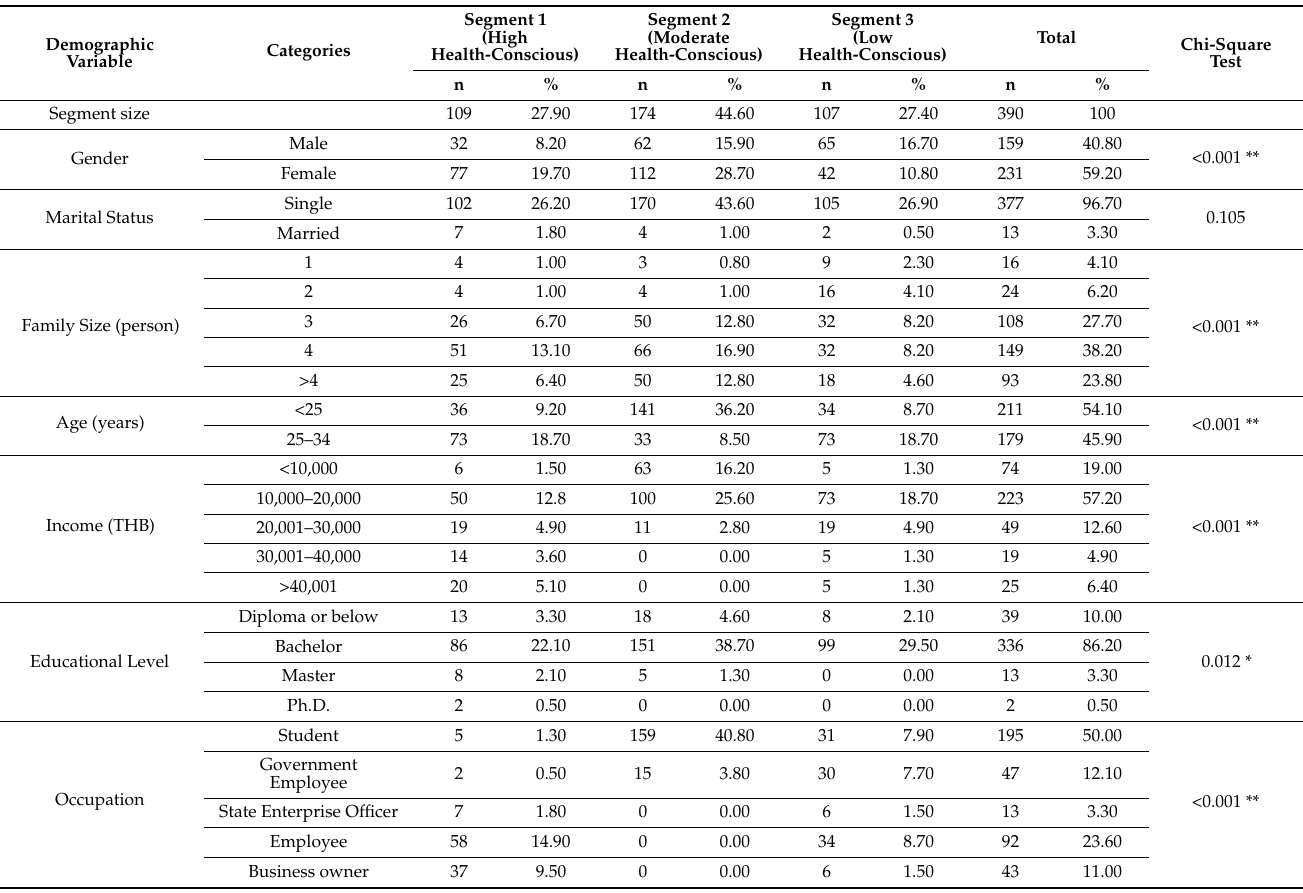
Table 3. The demographic profiles (descriptive statistics) of the study